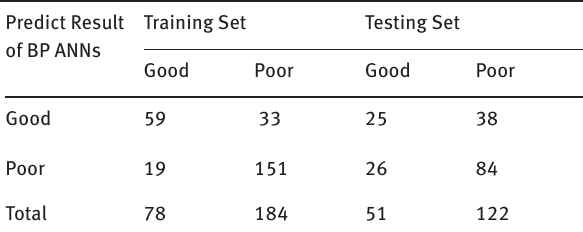
Figure 1: ROC curve of BP ANNs model and logistic regression model (p<.05) Table 4: Discriminatory Outcomes of Multiple Logistics Regression Model Predict Result of